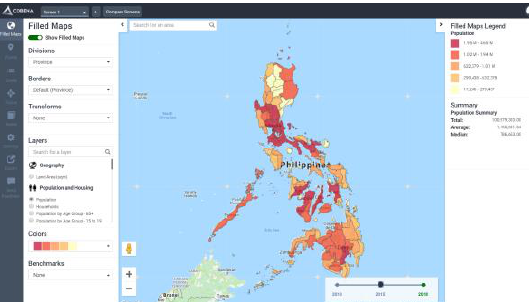
Figure 1. Snapshot: Choropleth display 2015 provincial populations, with legend and summary statistics.